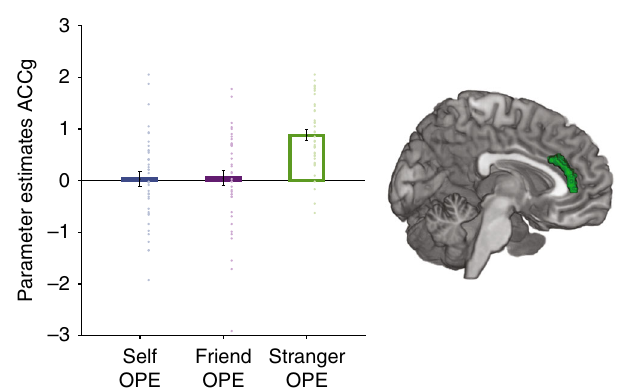
Fig. 5 Speci fi c coding of ownership prediction errors (OPEs) for strangers in ACCg. ACCg (area 24) speci fi cally coded ownership prediction errors when learning about the ownership of strangers ( p < .03, FWE-SVC for an anatomical mask of the medial prefrontal cortex). Activation overlaid on an anatomical scan of the medial surface. Error bars indicate standard error of the mean. N =